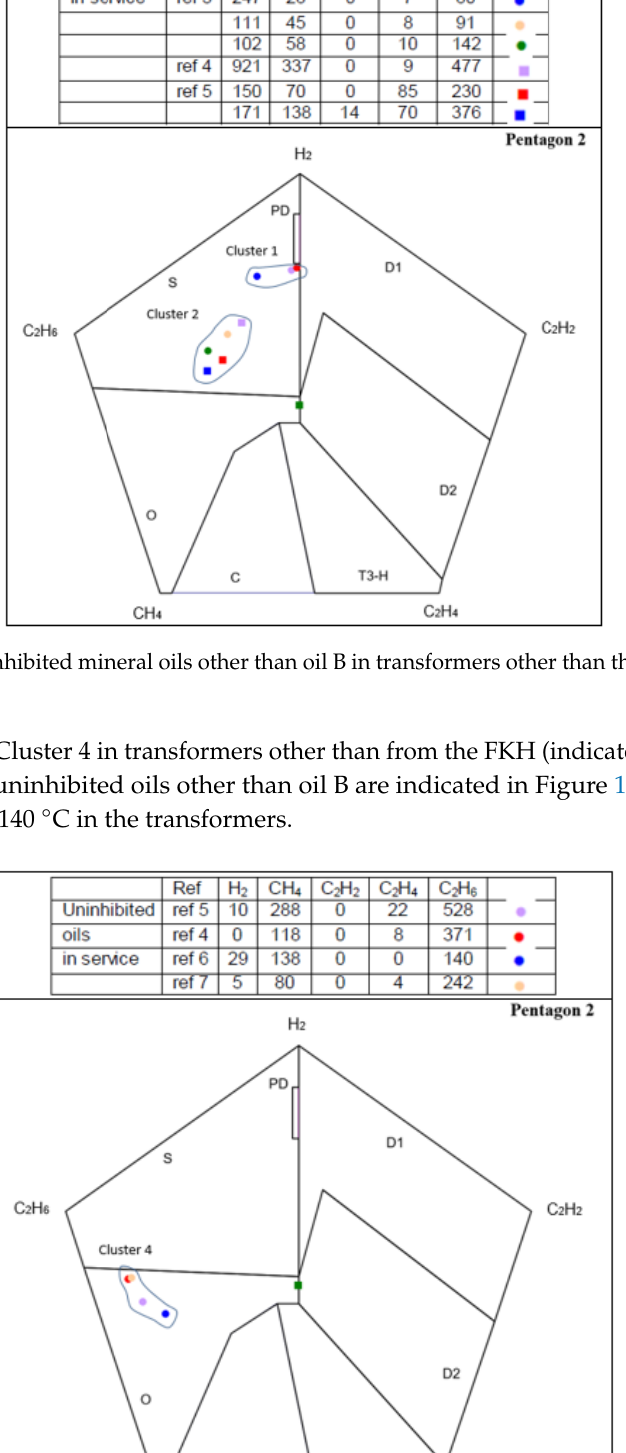
Figure 10. SG of uninhibited mineral oils other than oil B in transformers other than those from the FKH, in Cluster 4.